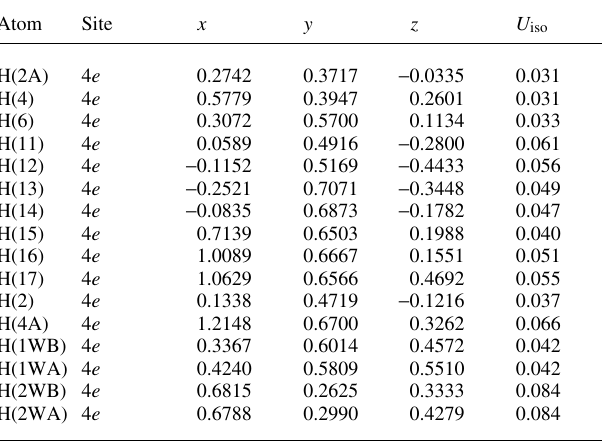
Table 2. Atomic coordinates and displacement parameters (in Å 2 )